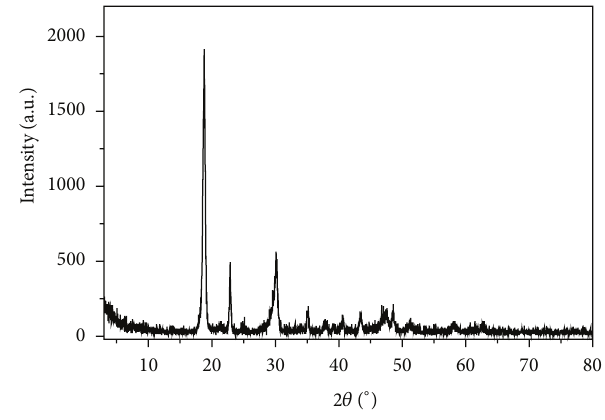
Figure 9: XRD pattern of the